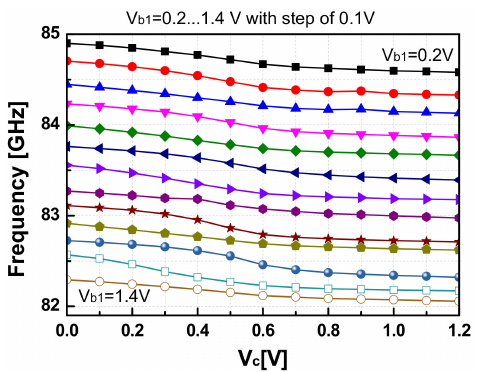
Figure 16. The measured oscillation frequency of the SA VCO as a function of V c = V c(fine)